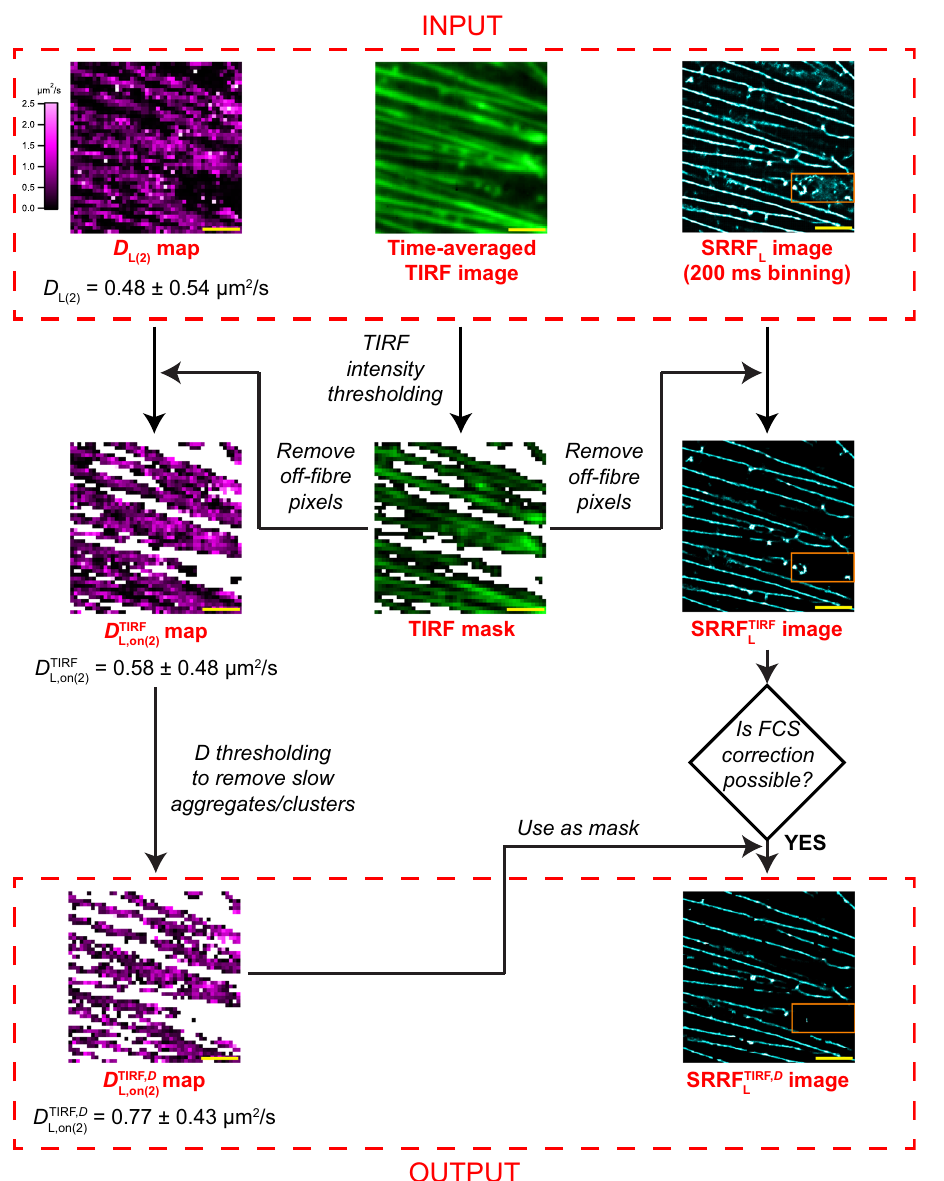
Fig. 3 Schematic outlining the strategy to improve the accuracy and precision of the D map, and its further use to correct the SRRF image. The untreated D L(2) map, TIRF image and SRRF image of a CHO-K1 cell expressing Lifeact-EGFP serve as the starting fi les. First, we create an intensity fi ltered TIRF mask which is then applied to the D L(2) map and SRRF image to remove the contributions from off- fi bre artefacts generating the D TIRF images respectively. The D TIRF map is then fi ltered by thresholding D values to remove the slow clusters. The resulting D TIRF L ; on ð 2 Þ image to generate the SRRF TIRF ; D image. For the dual-colour measurements, the Lifeact SRRF image is fi ltered only by remove artefacts from the SRRF TIRF L L using the TIRF image as a mask. The orange box indicates an area that contained artefacts in the original SRRF L image and are now removed in the SRRF TIRF ; D L